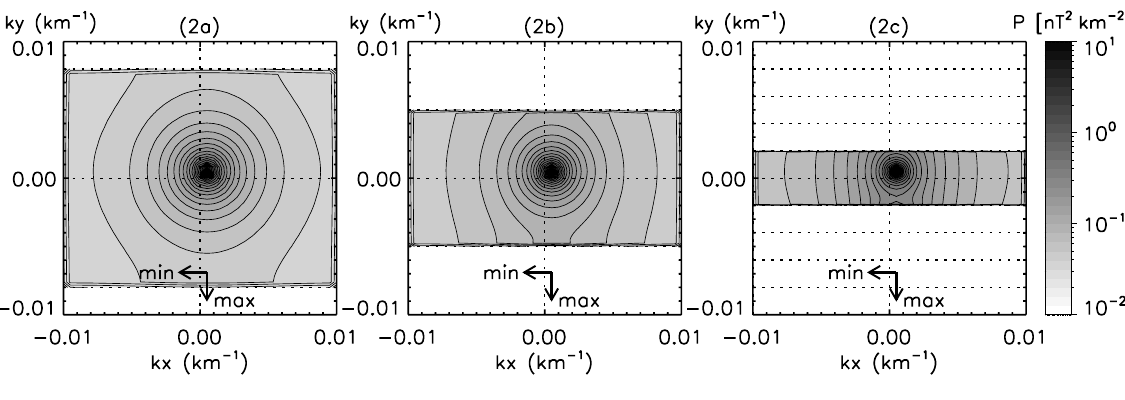
Fig. 7. Aliased spectra for different rectangular cell shapes of the Brillouin zone, close to right square (left), moderately narrow in the vertical reciprocal vector length (middle), even narrower in that length (right). The dotted lines are parallel to the reciprocal vectors.